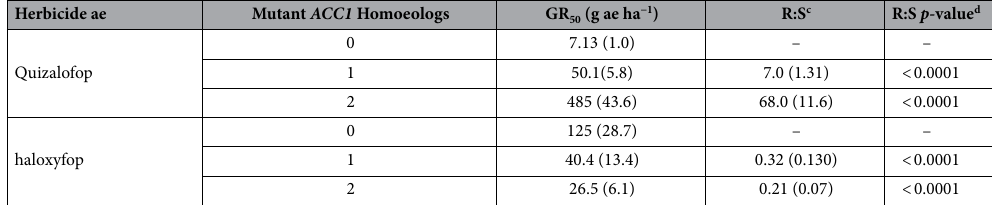
Table 1. Relative herbicide dose effects on whole-plant growth by genotype a for 50% growth reduction (GR 50 ) b . a Genotype refers to the number of homozygous mutations in ACC1 that result in a A2004V amino acid substitution, with up to three possible on group 2 chromosomes in hexaploid wheat (2n = 6x). b Leaf fresh weight values (g) normalized to percent untreated controls and transformed with Box-Cox transformation per genotype for each herbicide. Quizalofop dose effect modeled with a 2-parameter log-logistic function and haloxyfop dose effect modeled with a 4-parameter Brain-Cousens function to estimate GR 50 values. c Resistance factor, calculated by dividing the GR 50 of a quizalofop-resistant genotype by the susceptible genotype GR 50 . d Student’s t-test p -value (α = 0.05) of resistance factor